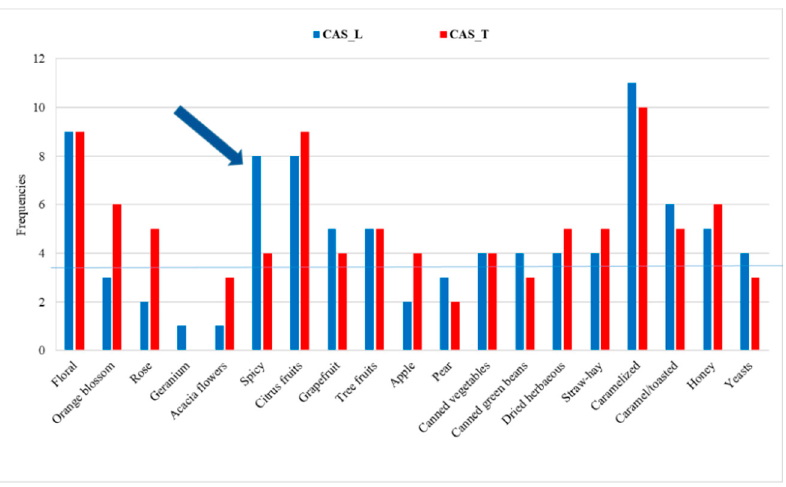
Figure 6. The frequencies of identification of odor attributes in the Latin and Tuscan beers.